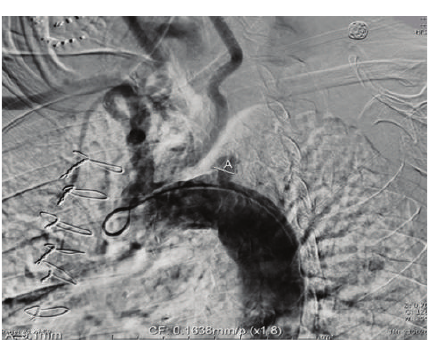
Figure 3: Thoracic aortogram with supra-aortic vessels. (A) Com- plete SA